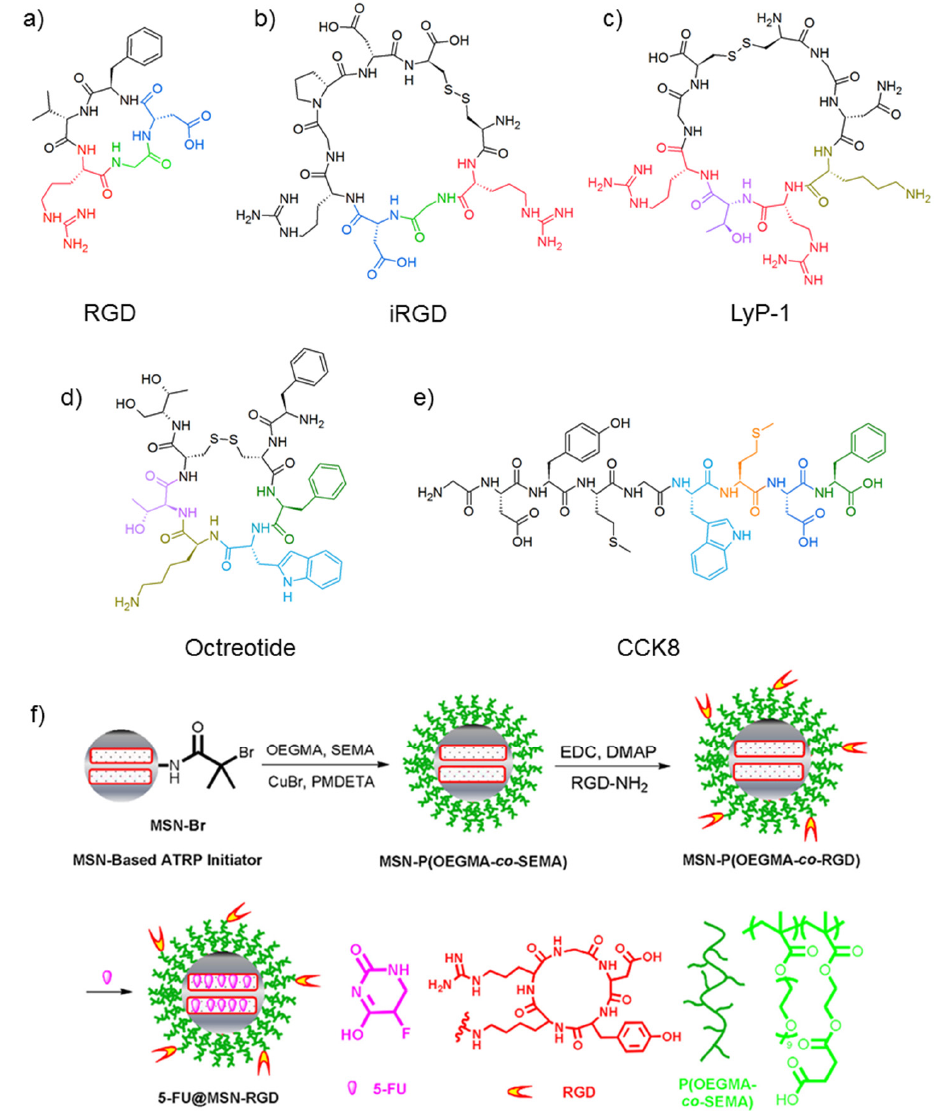
Figure 2. Chemical structure of peptide receptor sequences ( a – e ). Recognition residues are reported in colors; ( f ) synthetic routes employed for obtaining mesoporous silica nanoparticles and their analogues loaded with 5-FU (5-FU@MSN-RGD). (Reprinted with permission from [39]).